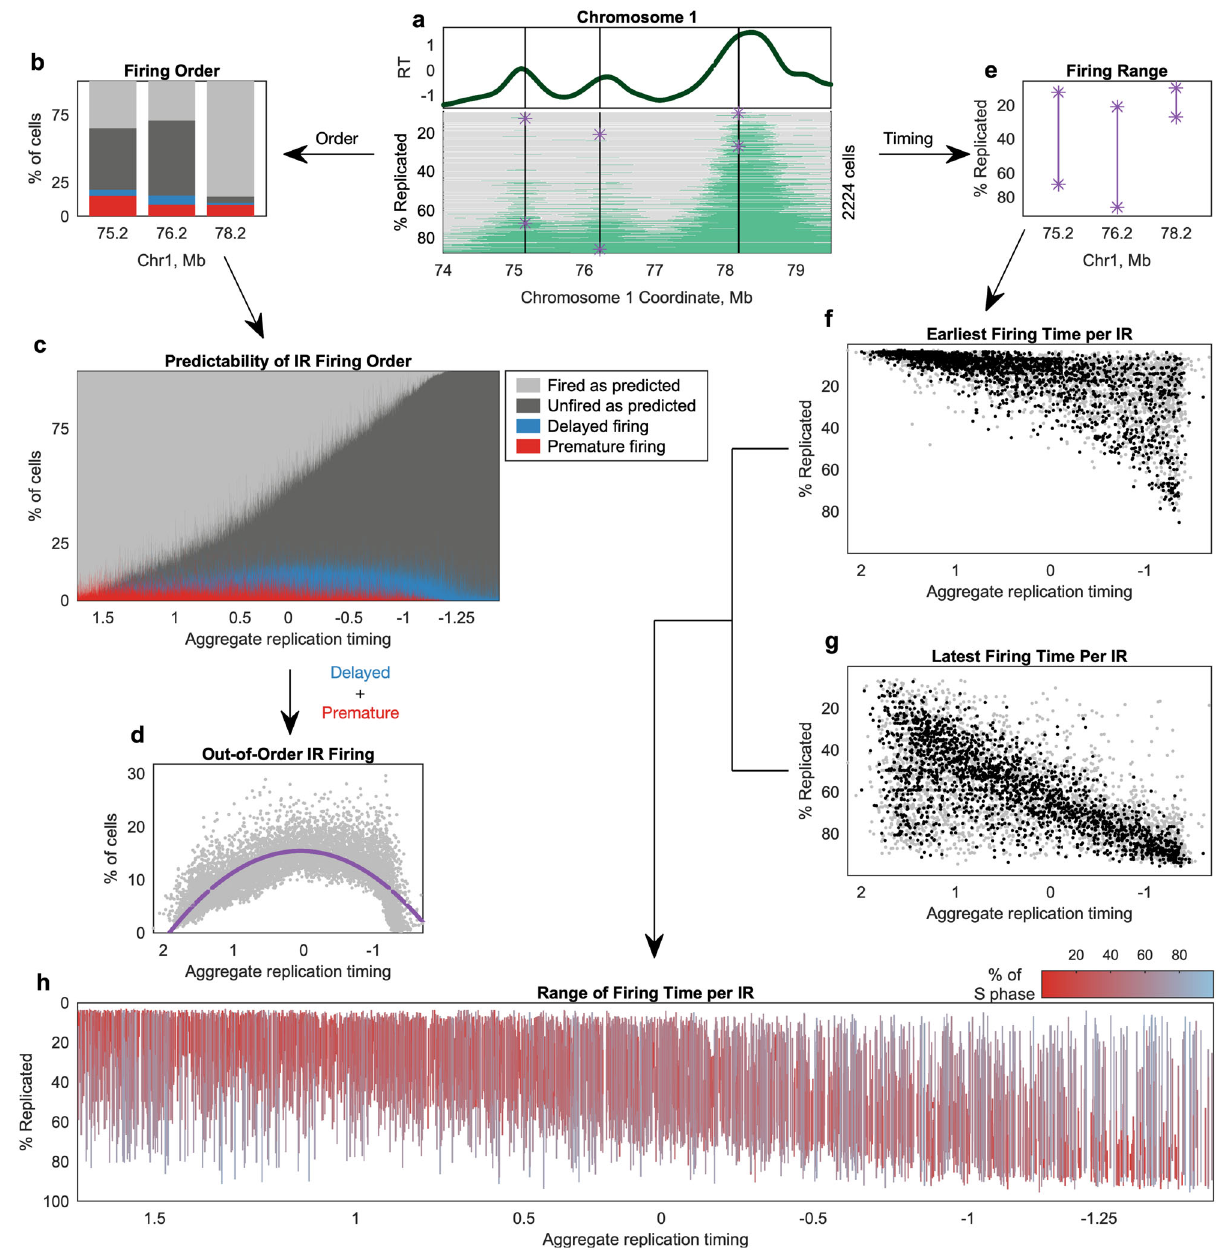
Fig. 4 Variation in the order and timing of replication initiation in single cells across S phase. a An example region illustrates analyses of IR fi ring order ( b – d ) and fi ring time ( e – h ). Black lines indicate the three IRs in b and e . Purple asterisks indicate the earliest and latest observed fi ring times. b IRs differ in their degree of consistency across cells. IRs were ranked from earliest to latest, allowing prediction of their replication state under a strict fi ring ordering. Cells that have replicated an IR not predicted to fi re are considered “ premature ” (red), while those that have not replicated an IR predicted to have fi red already are “ delayed ” (blue). c IRs are fi red in the expected order in most cells. Columns represent IRs, ranked from earliest to latest (left-to-right). d IR fi ring varies most for IRs expected to fi re in mid-S phase. On average, IRs behaved differently than expected in 11.1% of cells (range: 0.3 – 29.7%). Dots represent IRs. The purple line shows a second-order polynomial fi t. e IR fi ring range spanned from the earliest observed fi red cell to the latest observed un fi red cell. S-phase progression was measured as percent of the genome replicated. f , g For each IR, we identi fi ed the least-replicated and most-replicated cell containing a replication track assigned to that IR. Dots represent IRs: black dots indicate IRs for which a second cell within 10% S-phase progression “ corroborated ” the earliest and latest fi ring time. h Aggregate early IRs tended to have narrower ranges of fi ring times than aggregate late IRs. Vertical lines represent IR fi ring range for IRs with corroborated values, color-coded by the % of S phase during which that IR fi res (i.e., the length of the line). A small number of constitutively late IRs (short red lines with late aggregate replication timing) can be